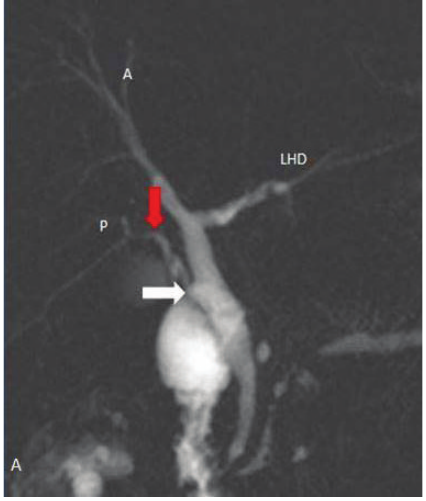
Figure8:Coronaloblique3DMRcholangiopancreatographyshows aberrant union of right segmental bile duct (red arrow) into the cystic duct (white arrow). Cystic duct (white arrow) unites laterally to form CBD. LHD: left hepatic